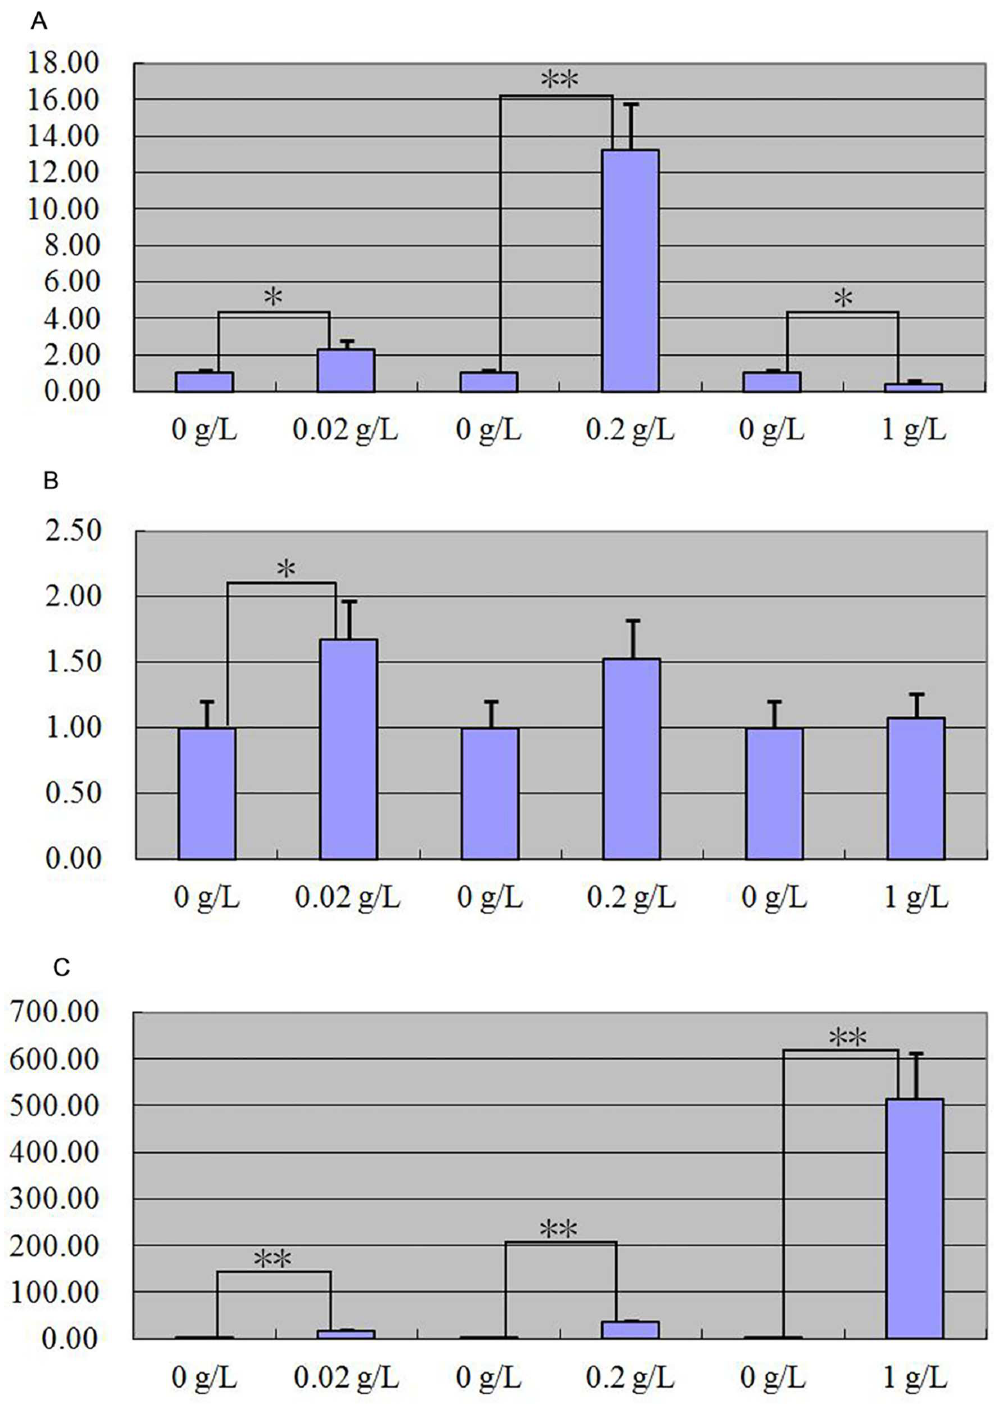
Fig 8. Expression quantity change of keratin 26 after MT treatment respectively was detected by quantitative real-time PCR. Fig 8A. Expressionquantity of keratin26 was2.31 × (p < 0.05), 13.21 × (p < 0.01) greater,0.41 × (p < 0.05)less in the groupswhichcellsweretreatedwith0.02g/L, 0.2 g/L, 1 g/L MT thanthe group whichcells weretreatedwith 0 g/L MT for 24 h. Fig 8B. Expression quantityof keratin26 was 1.67 × (p < 0.05), 1.52 × (p > 0.05)and1.07 × (p > 0.05)greaterin the groupswhichcellsweretreatedwith0.02g/L, 0.2 g/L, 1 g/L MT thanthe groupwhichcells weretreatedwith 0 g/L MT for 48 h. Fig 8C. Expressionquantity of keratin26 was 15.99 × (p < 0.01), 35.15 × (p < 0.01), 513.36 × (p < 0.01)greaterin the groupswhichcells weretreatedwith 0.02g/L, 0.2 g/L, 1 g/L MT thanthe groupwhichcells weretreatedwith 0 g/LMT for 72